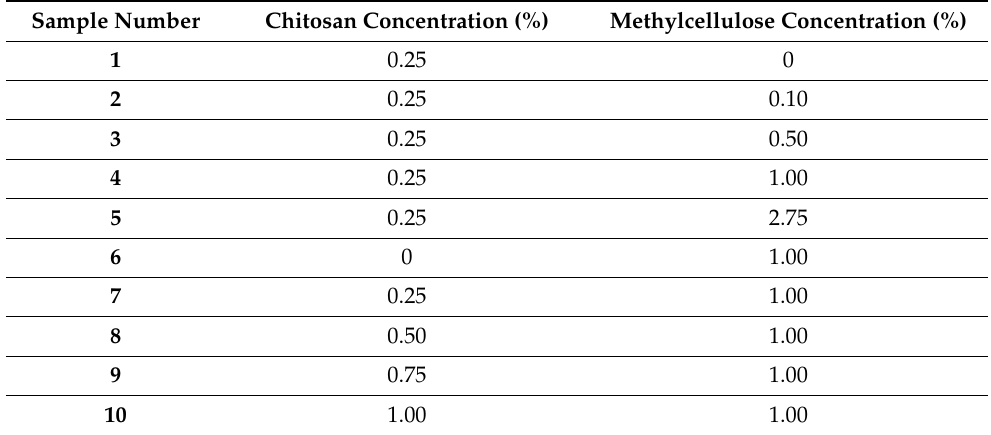
Table 1. Smart Gel Sample